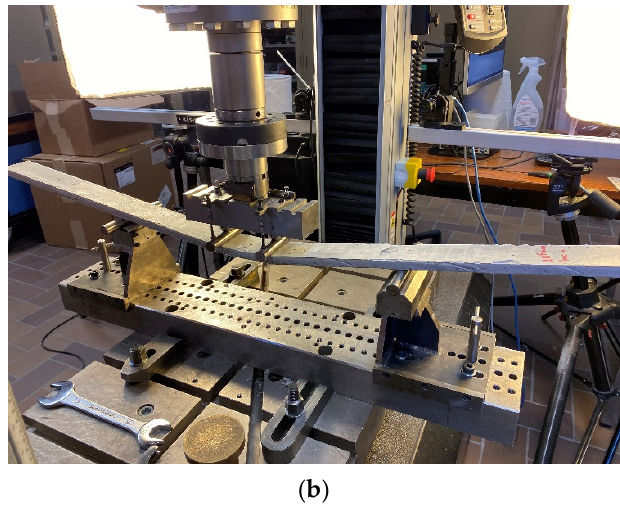
Figure 6. Four-point bending test setup: ( a ) schematic of the experimental setup; ( b ) picture of a loaded beam with DIC cameras.